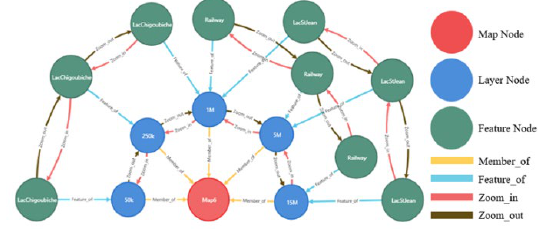
Figure 3 . System Structure.